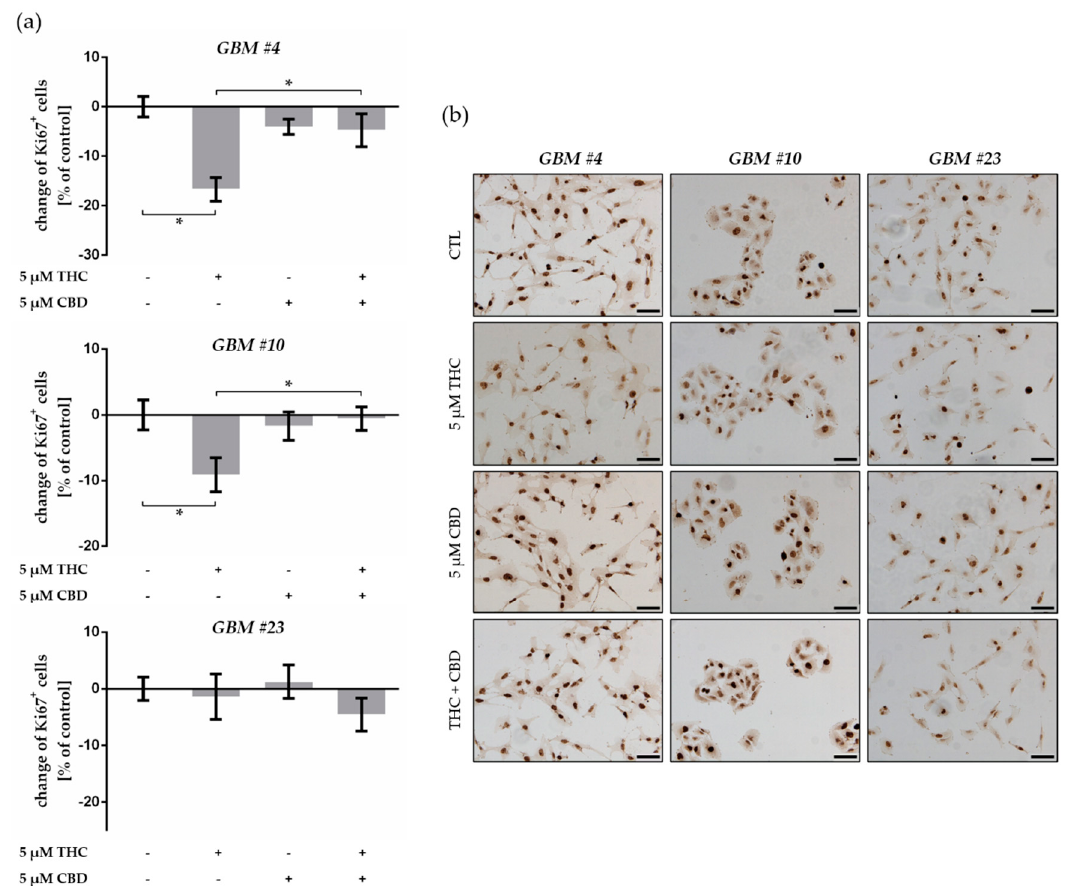
Figure 2. Impact of ∆ 9 -tetrahydrocannabinol (THC) and cannabidiol (CBD) on proliferation capacity of human patient-derived GBM cells. ( a ) Effects of THC and CBD on the number of Ki67-labelled GBM cells. In comparison to control group, application of THC (5 µ M) for 24 h produced a significant reduced number of Ki67 + cells in GBM #4 and GBM #10, but not in GBM #23 . Alterations after treatment with CBD (5 µ M) were not observed, but in combination with THC it reversed the effects of THC in GBM #4 and GBM #10 . Data are means ± SEM of N = 3 independent experiments performed in duplicate. Significance was chosen for p < 0.05. The asterisk denotes significant results regarding the respective measurement indicated with the bar. ( b ) Representative images of Ki67-immunoreactive GBM cells (Ki67 + in brown and Ki67 - in blue) untreated (CTL) or treated with THC (5 µM), CBD (5 µM), and an equimolar combination of THC and CBD after 24 h. Nuclei were counterstained using hematoxylin. Scale bar = 75 µm.